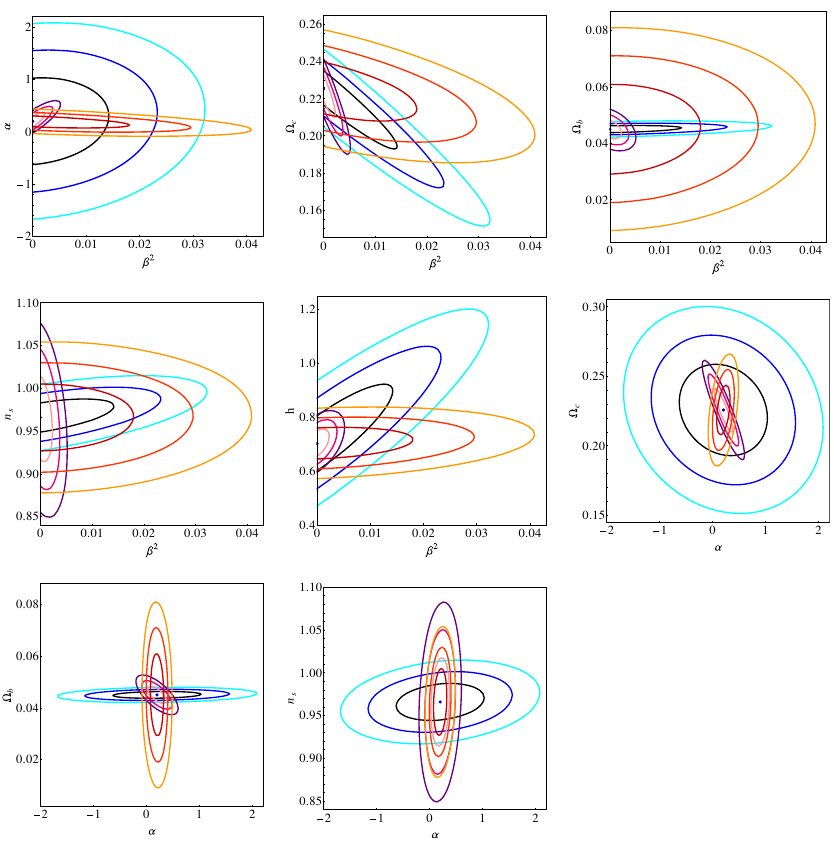
Fig. 34 Comparison among predicted confidence contours for the cosmological parameter set Θ ≡ { β 2 ,α,Ω c , h ,Ω , n s ,σ , log ( A ) } using CMB (Planck, blue contours), P ( k ) (pink-violet contours) and 8 b weak lensing (orange-red contours) with Euclid-like specifications. Image reproduced by permission from Amendola et al. (2011), copyright by